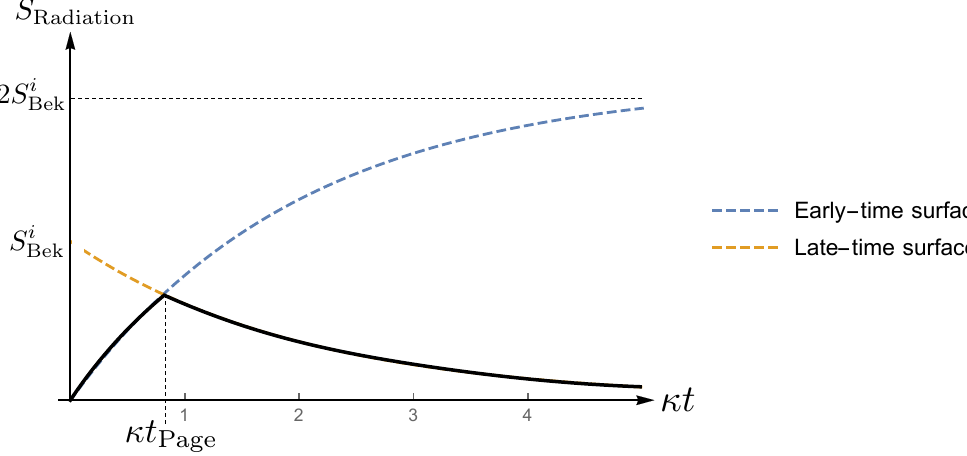
Figure 11 . Sketch of the entropy of the radiation, computed using the early time surface and the late time one. We are assuming that S 0 (cid:28) S i time. Here (cid:20) is proportional to c and also to the e(cid:11)ective gravitational coupling of the 2d gravity